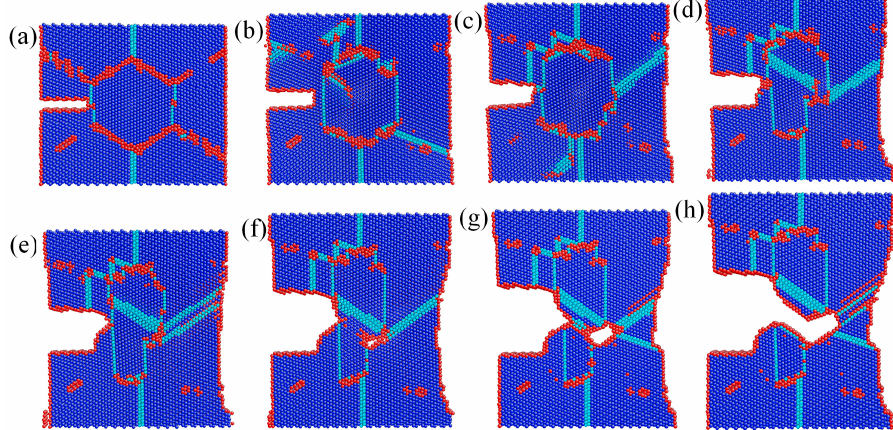
Figure 5. Evolution of atomic configuration for crack propagation in polycrystal nickel at the strain rate of 2 × 10 8 s − 1 : ( a ) ε = 0; ( b ) ε = 0.06; ( c ) ε = 0.12; ( d ) ε = 0.18; ( e ) ε = 0.24; ( f ) ε = 0.36; ( g ) ε = 0.42; ( h ) ε = 0.48. (All the configurations are characterized by common neighbor analysis (CNA), where hexagonal close-packed (HCP) atoms were displayed by light blue color, face-centered cubic (FCC) atoms were expressed by dark blue color and non-3D-crystalline atoms were exhibited by red color).